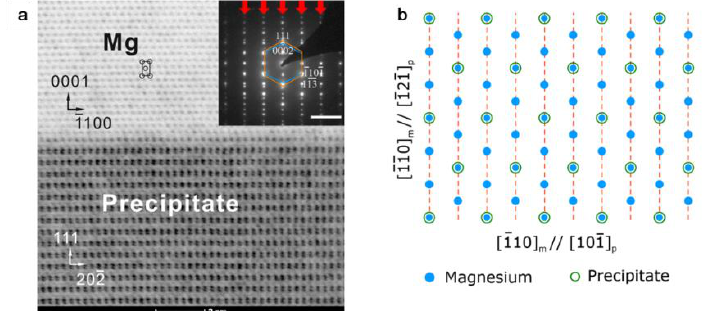
Figure 6. Transmission electron microscopy (TEM) observation of Al 2 Gd type precipitate in an Mg-Al-Gd alloy. ( a ) Bright field image of Mg / Al 2 Gd interface from the [ − 1 − 120] Mg // [ − 12 − 1] Al2Gd zone axis. ( b ) The atomic row matching in the Mg / Al 2 Gd interface. The inserted figure in ( a ) is the di ff raction